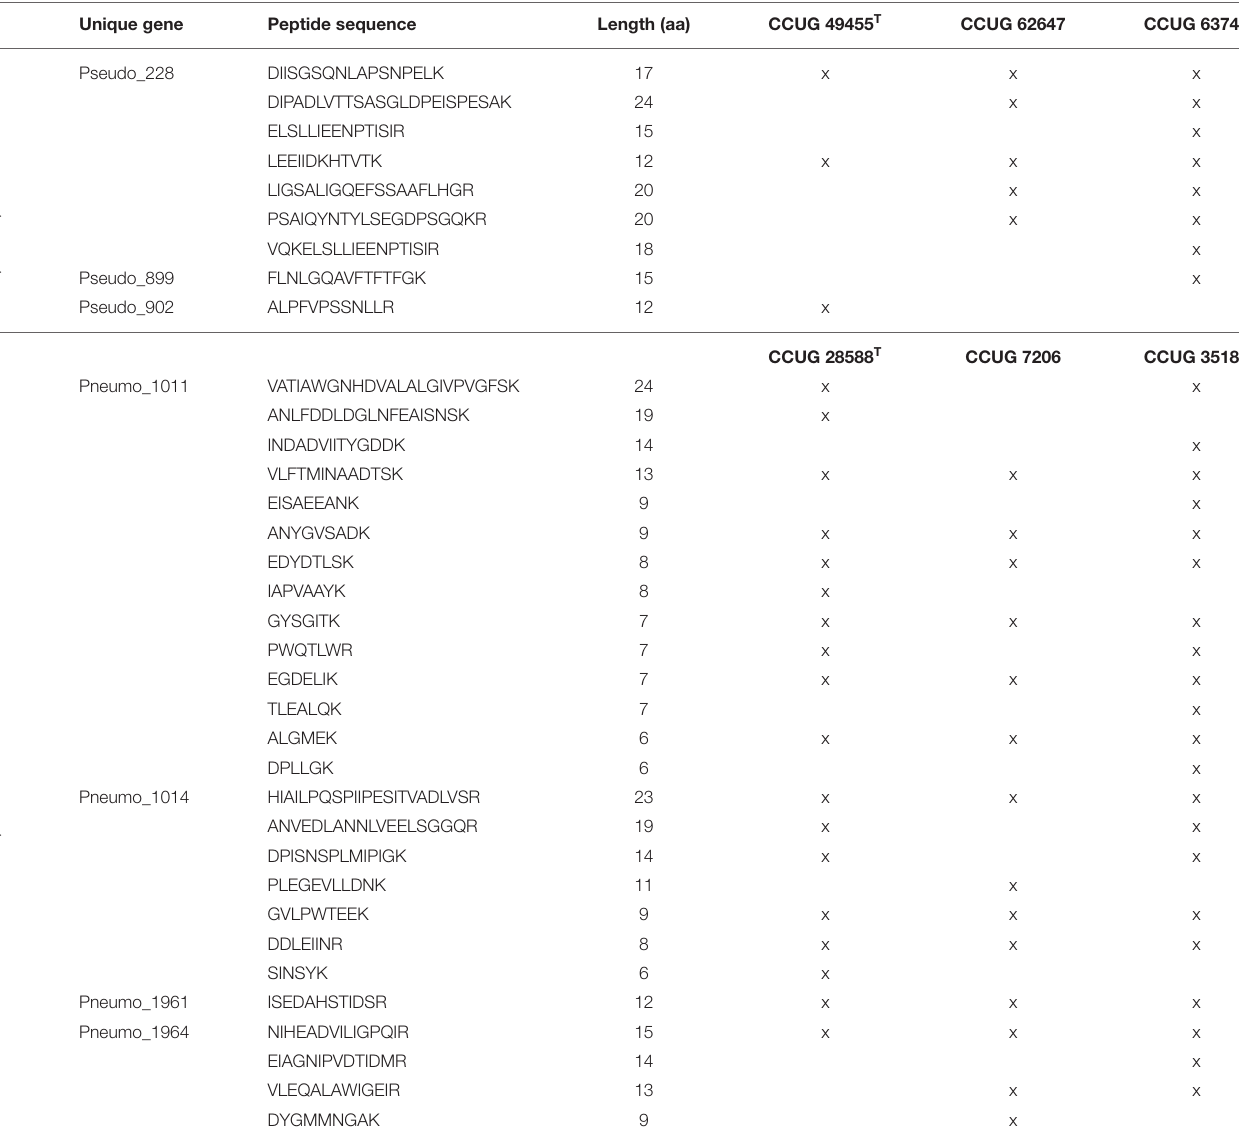
TABLE 6 | List of the peptides detected from the unique genes of S. pneumoniae and S. pseudopneumoniae when analyzed using inclusion lists and targeted proteomics. Unique gene Peptide